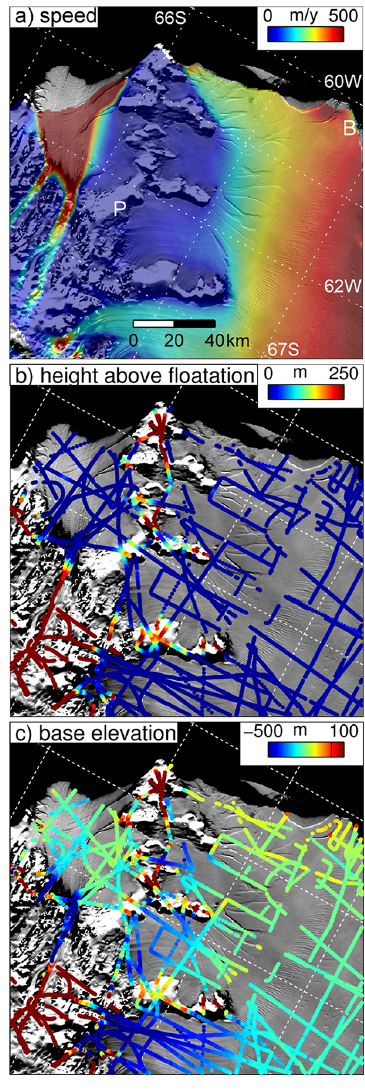
Figure 9. Northern LCIS and Jason Peninsula, showing various quantities overlain on MODIS Mosaic of Antarctica (Scambos et al., 2007): (a) ice flow speed (Rignot et al., 2011); (b) height of ice surface above hydrostatic floatation; (c) elevation of ice base rela- tive to sea level. Bawden Ice Rise is labelled B and Philippi Rise is labelled